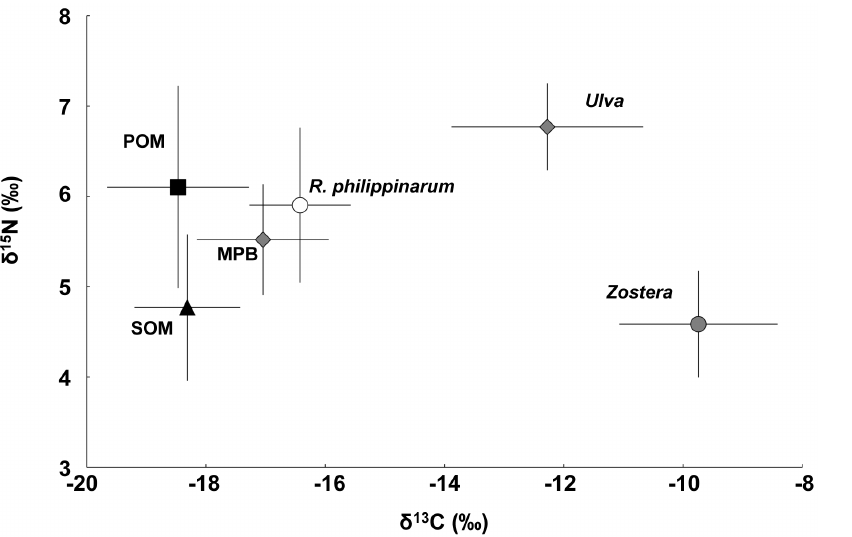
Figure 6. A dual isotope plot for carbon and nitrogen for the expected diet of the clam ( Ruditapesphilippinarum ) and their potential food sources in Hichirippu Lagoon. See text in Materials and methods for diet-tissue fractionation for the clam to determine expected diet ( R. philippinarum ). Error bars are standard deviations. doi:10.1371/journal.pone.0086732.g006 PLOS ONE |